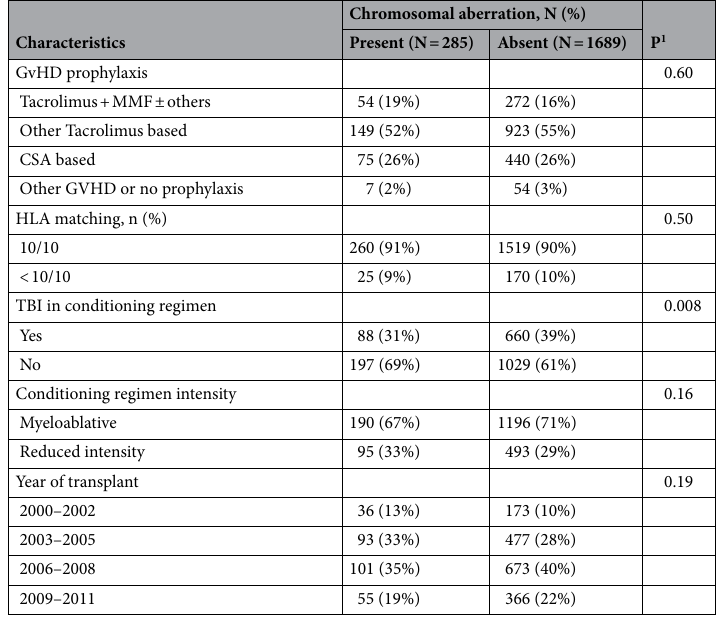
Table 1. Patient characteristics. 1 Pearson Chi-square test unless otherwise specified. 2 Fisher’s exact test.